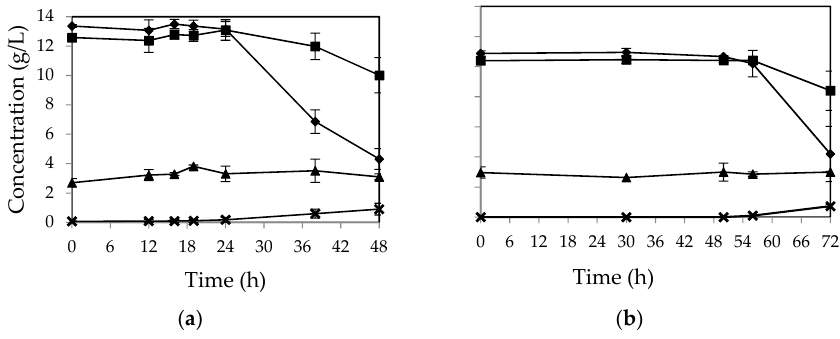
Figure 2. Concentration of ( ▲ ) sucrose, ( ♦ ) glucose, ( ■ ) fructose, and (×) ethanol in cultivation of ( a ) M. indicus and ( b ) R. oryzae on CWFS without any nutrient in baffled shake flasks. Data are means ± SD, n = 2.